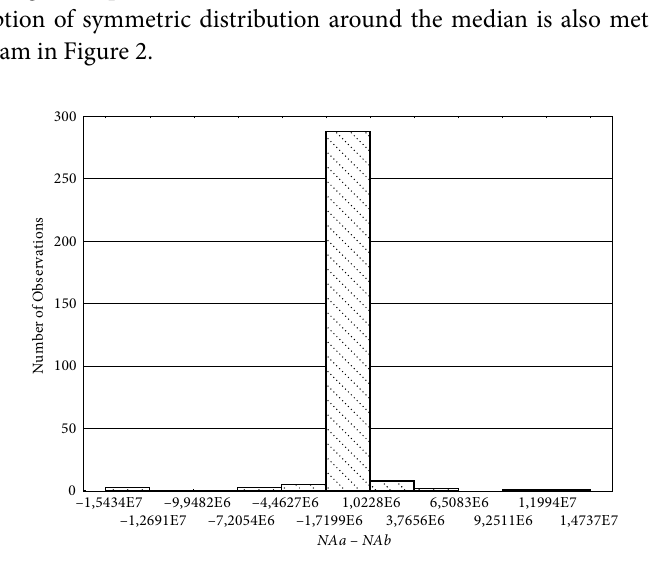
Fig. 2. Histogram NAa – NAb for all participating companies